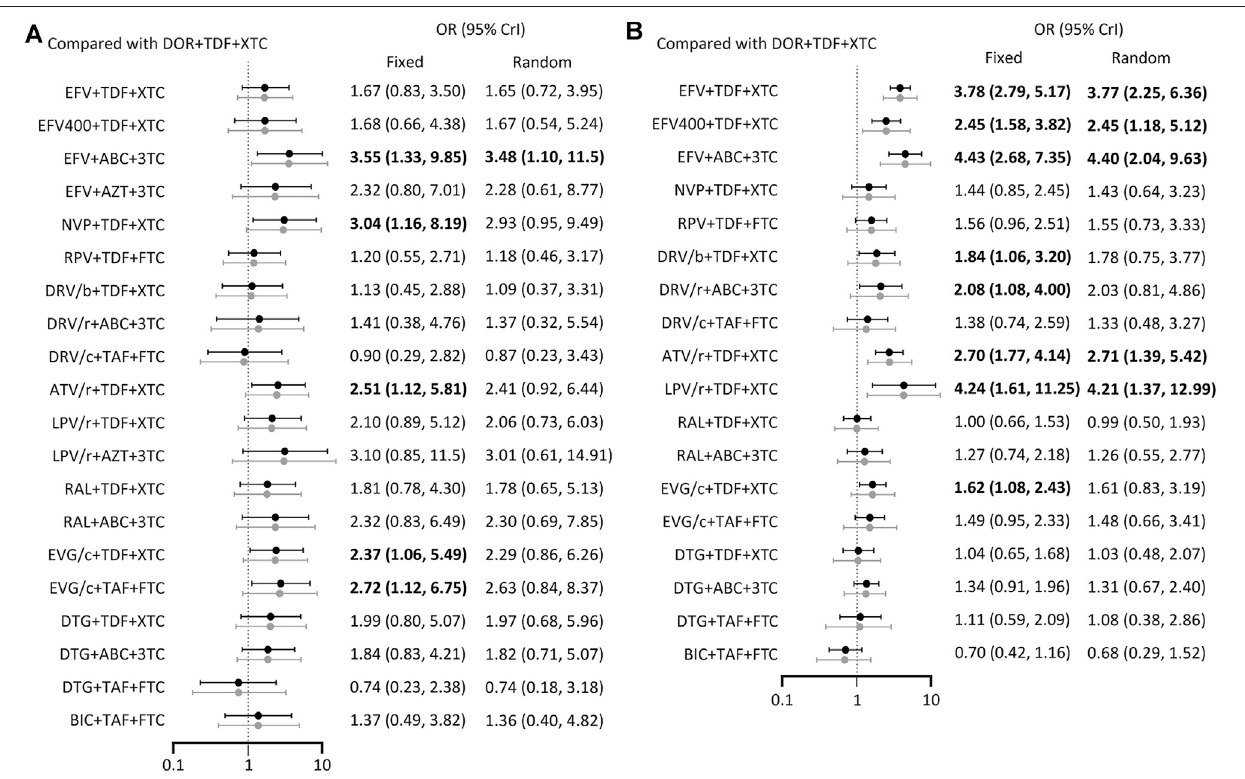
Frontiers in Pharmacology |